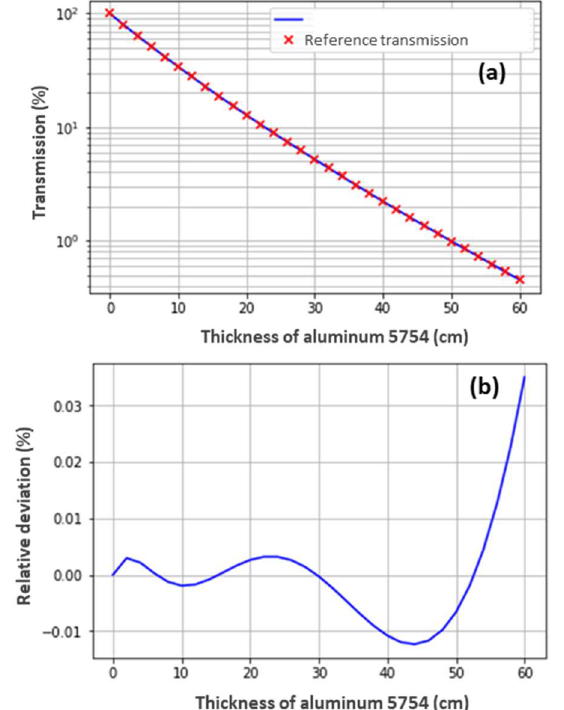
Fig. 7. Estimated average energy spectrum in linear (a) and logarithmic (b) scales after noise suppression of the reference transmission, with the green error bars representing the uncertainty of each channel For each channel the uncertainty is represented by the green error bars in Fig. 7. The average uncertainty per channel with respect to the average spectrum is 3.5.10 -4 (defined by (5)), which is twice as large as for the noiseless estimate of the transmission curve. The noisy reference transmission curve and the estimated average spectrum curve are plotted in Fig. 8.